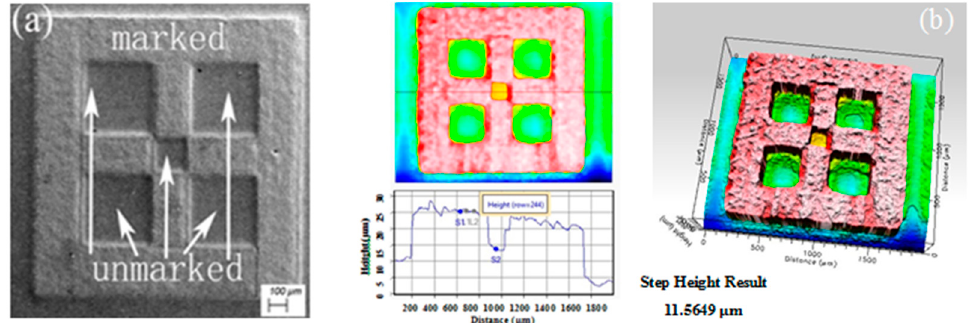
Figure 9. SEM image and 3D profile of the masked laser cavity: ( a ) SEM images of micro-machined mask and non-masked area; ( b ) 3D contour image of the micro-machined mask and non-masked